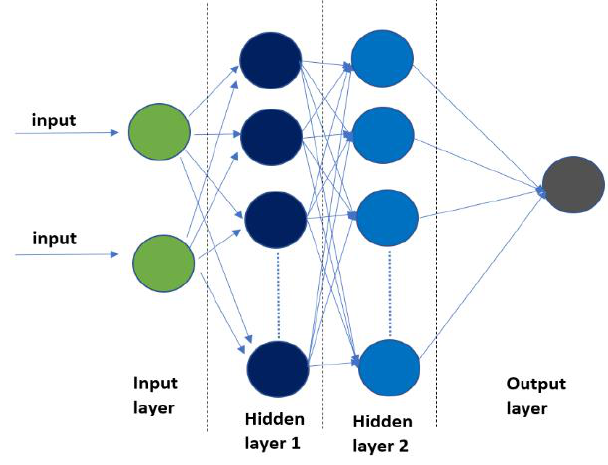
Figure 4. Architecture of artificial neural network (ANN).